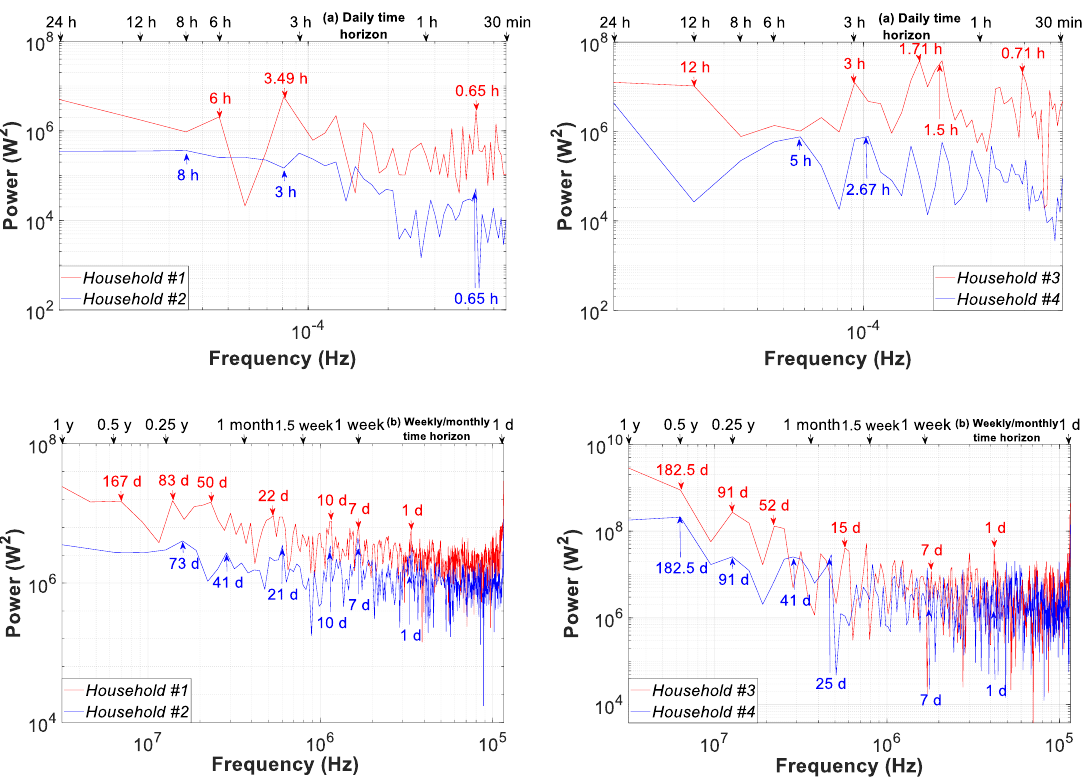
Figure 17. Autocorrelation function of the consumption load profile in households #1 to #4 for four data granularities.